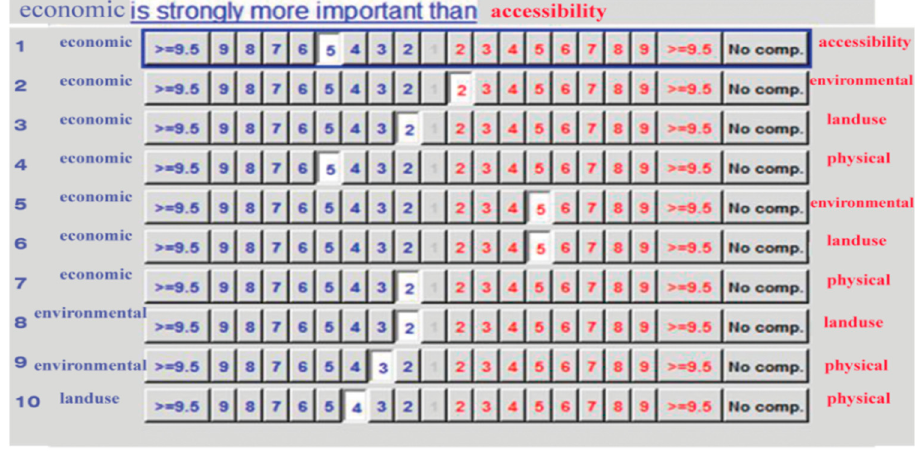
Figure 4. The result of the pairwise comparison of the criteria presented in Figure 4 from Super Decisions V2.8 software.